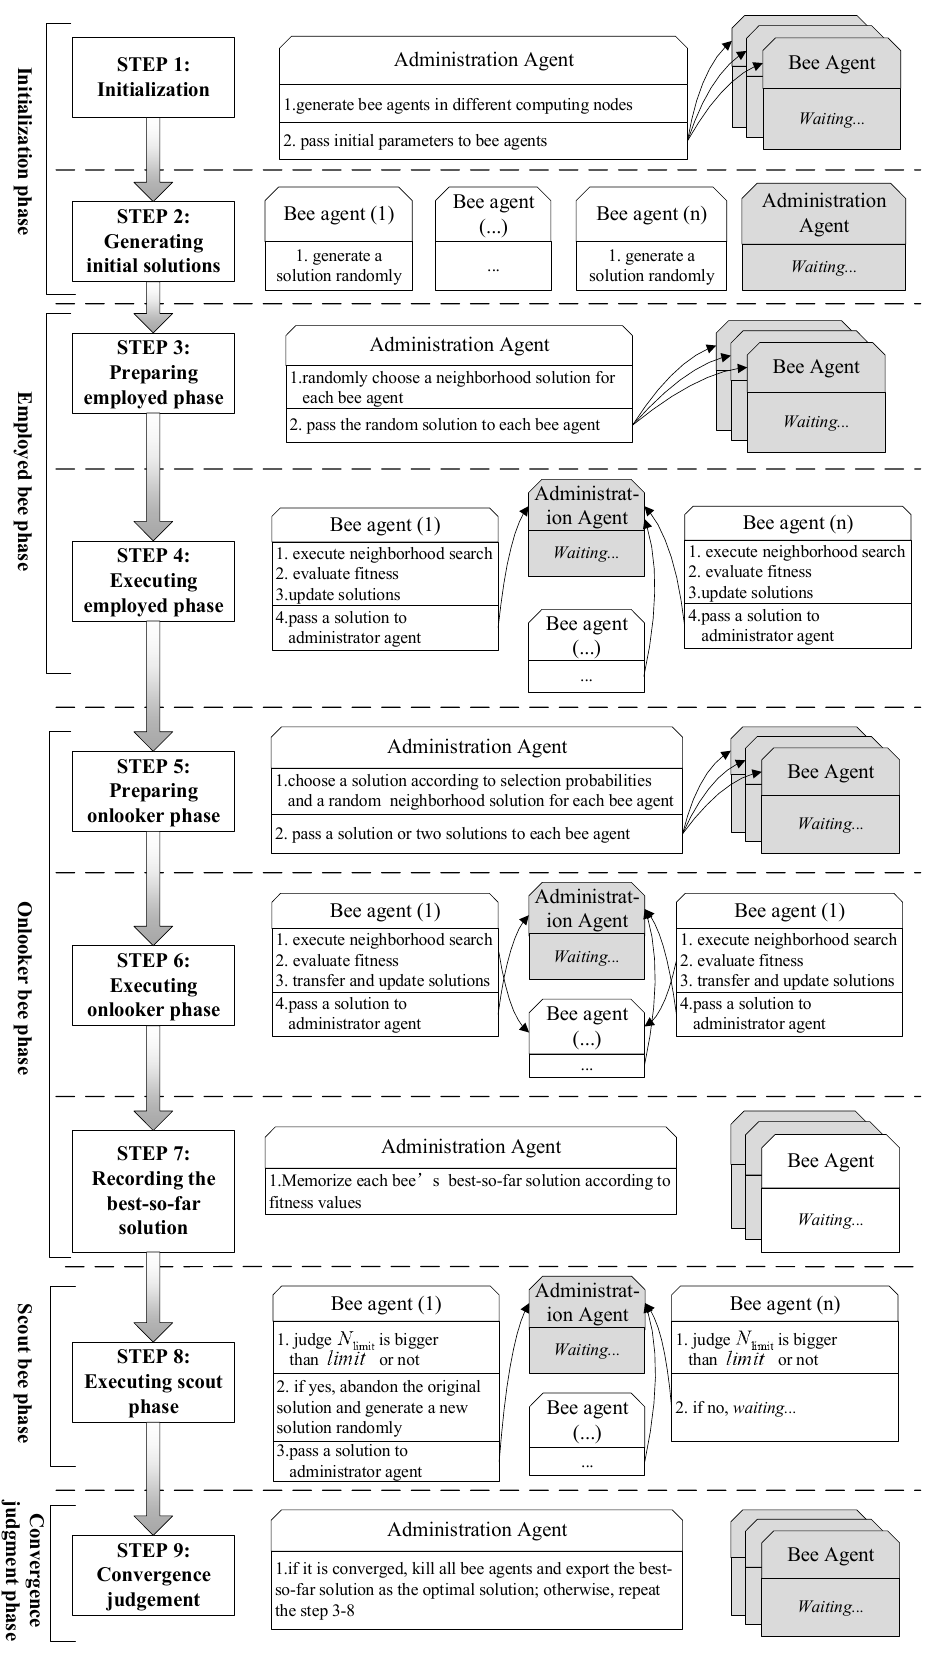
Figure 3 The overall workflow of agents’ behaviors for remote sensing (RS) clustering. Figure 3. The overall workflow of agents’ behaviors for remote sensing (RS)